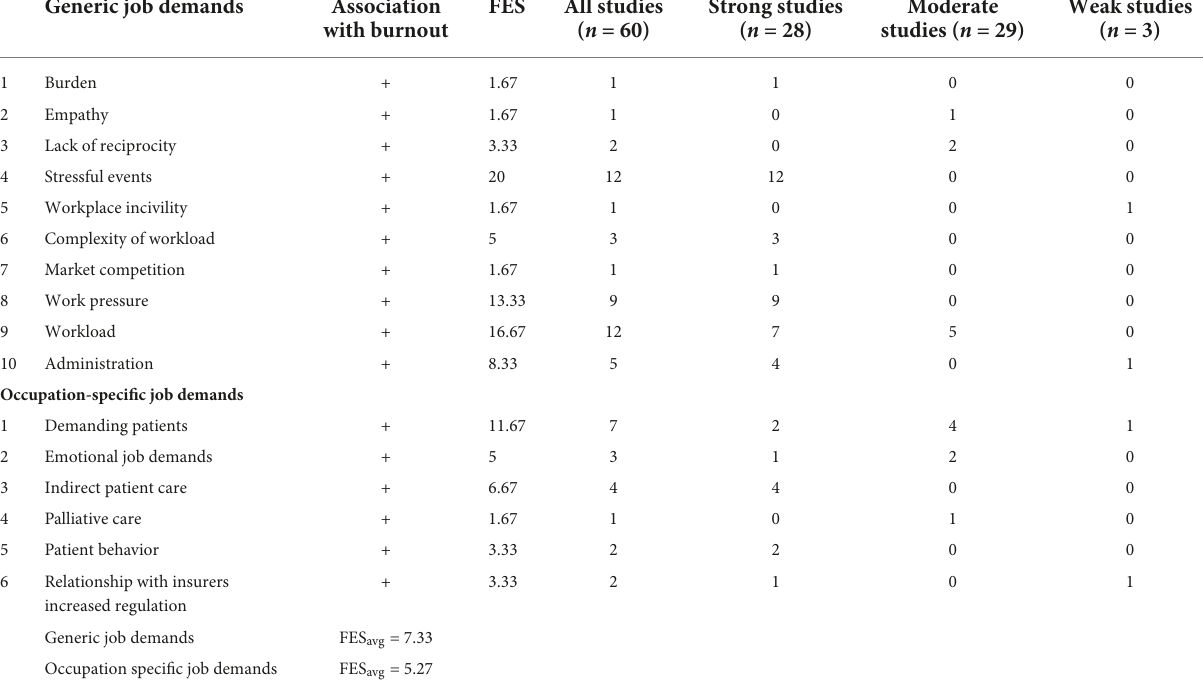
TABLE 2 Study outcomes job